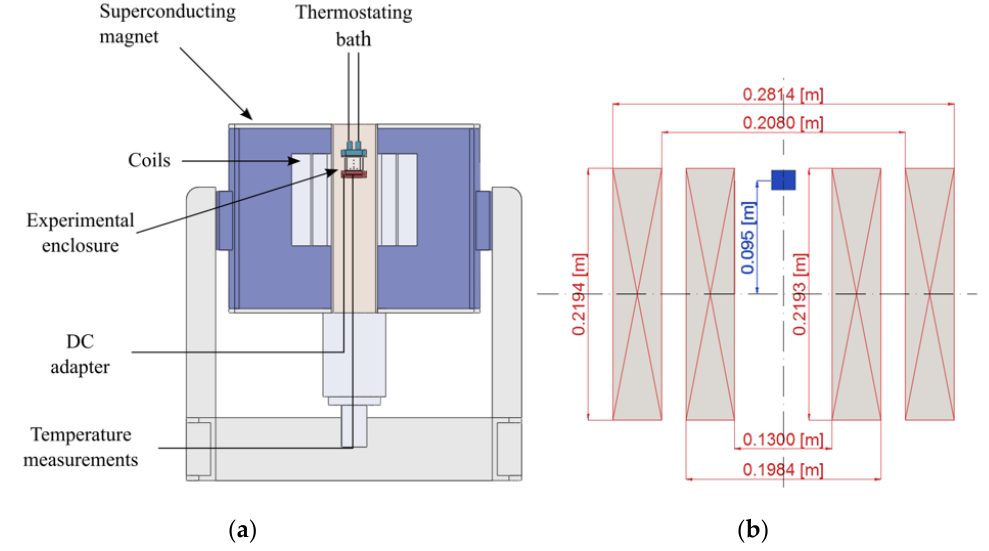
Figure 2. A schematic view of the experimental setup ( a ) and dimensions of the magnet’s coils ( b ).